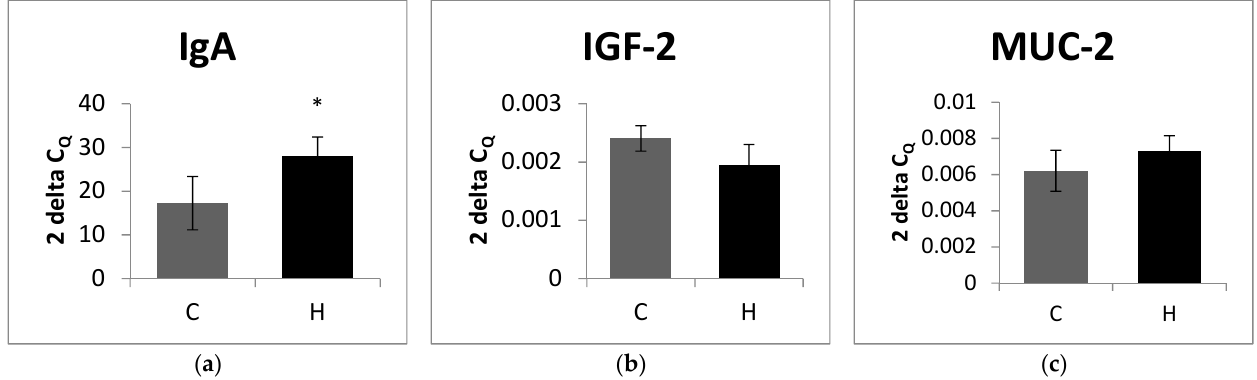
Figure 1. Relative expression of IgA (a), IGF-2 (b), and MUC-2 (c) genes in cecum of laying hens treated with 0.5% HS. Results at each time point are the median of 2 – Δ Cq . C: control group; H: layers fed a diet enriched with supplementation of 0.5% HS. Columns marked with stars are significantly different from control: * p < 0.05.